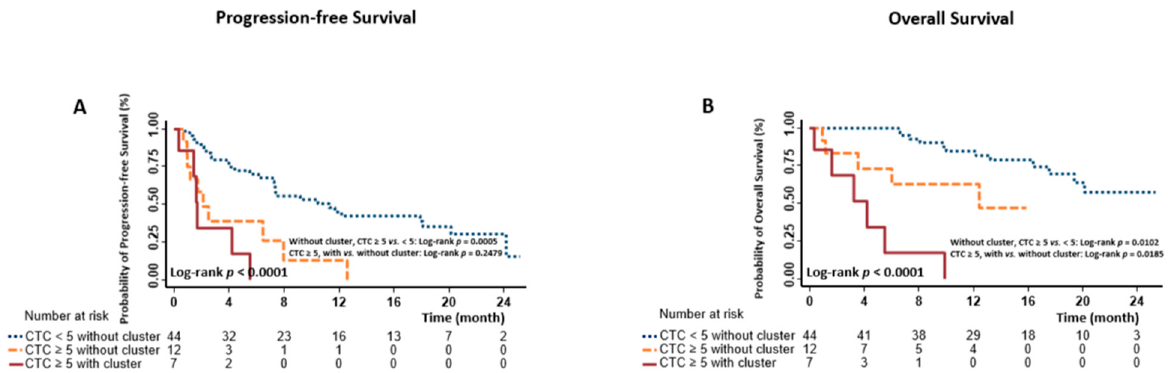
Figure 2. Kaplan-Meier estimates of the probability of progression-free survival (PFS) and overall survival (OS) in mCRPC. Survival differences were compared among those with <5 CTCs and 0 CTC-cluster, with ≥ 5 CTCs and 0 CTC-cluster, and with ≥ 5 CTCs and ≥ 1 CTC-clusters (( A ) for PFS and ( B ) for